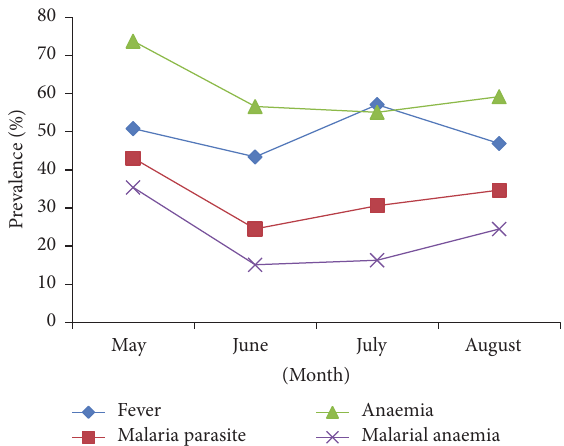
Figure 2: Monthly prevalence of fever, malaria parasite, anaemia, and malarial anaemia during the study period.